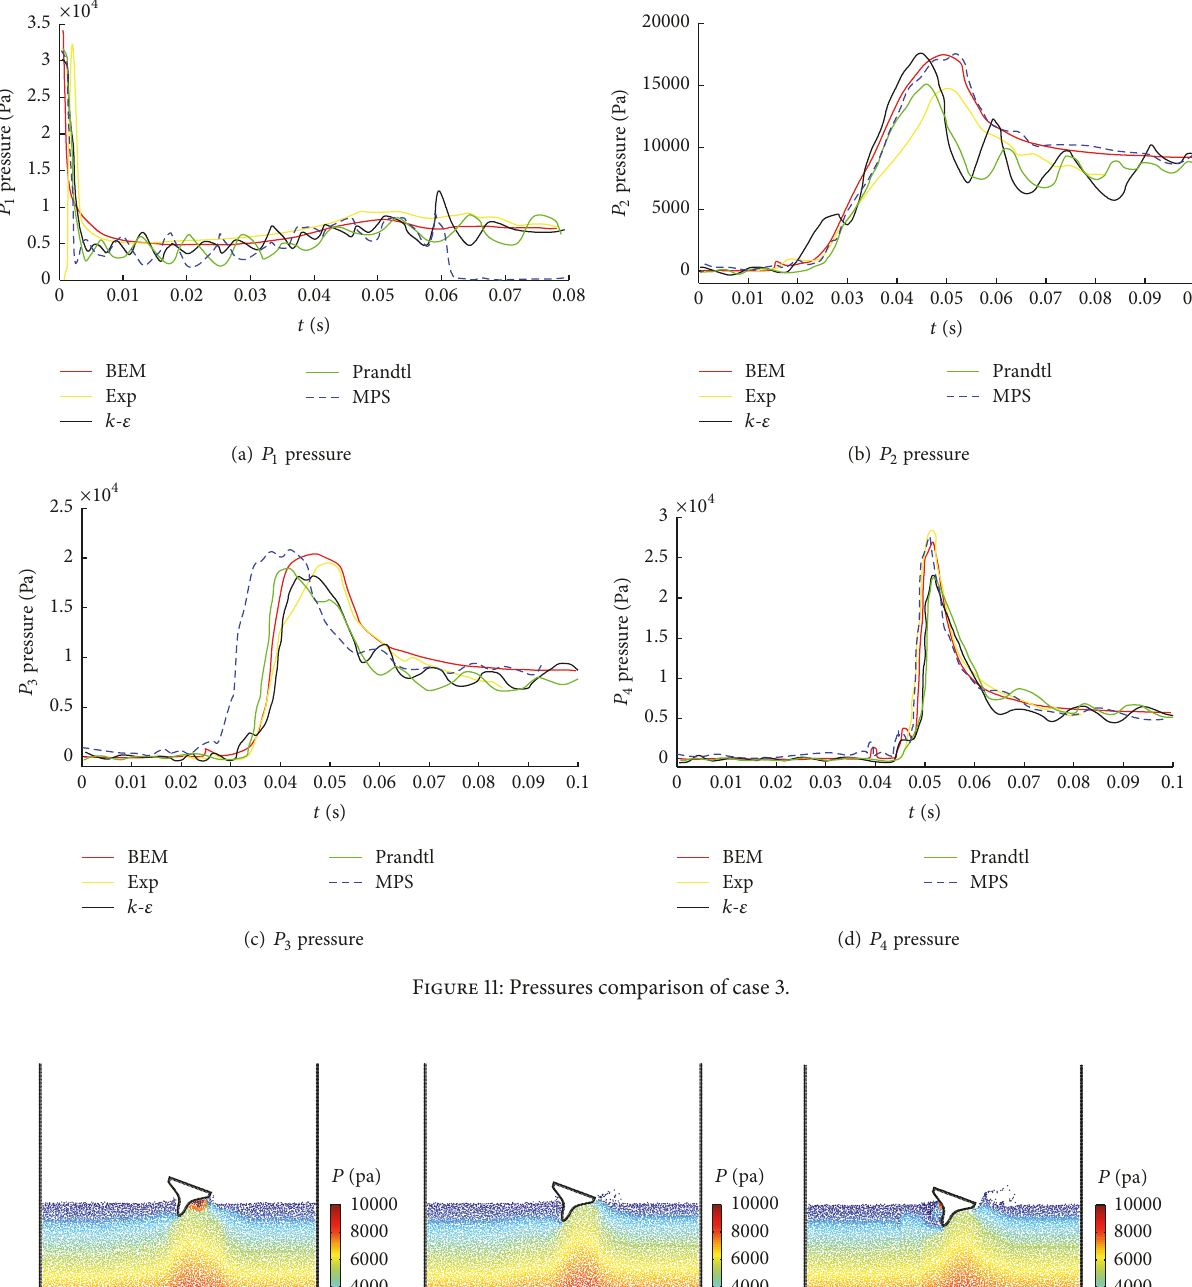
at the left side arrives at the section surface the slamming force reaches another peak value; the two peak values are not equal which is caused by the asymmetry between the left and the right sides. As shown in case 2 and case 3, it is clear that the slamming force is more serious when the entry velocity is higher. After the bottom slamming the flow